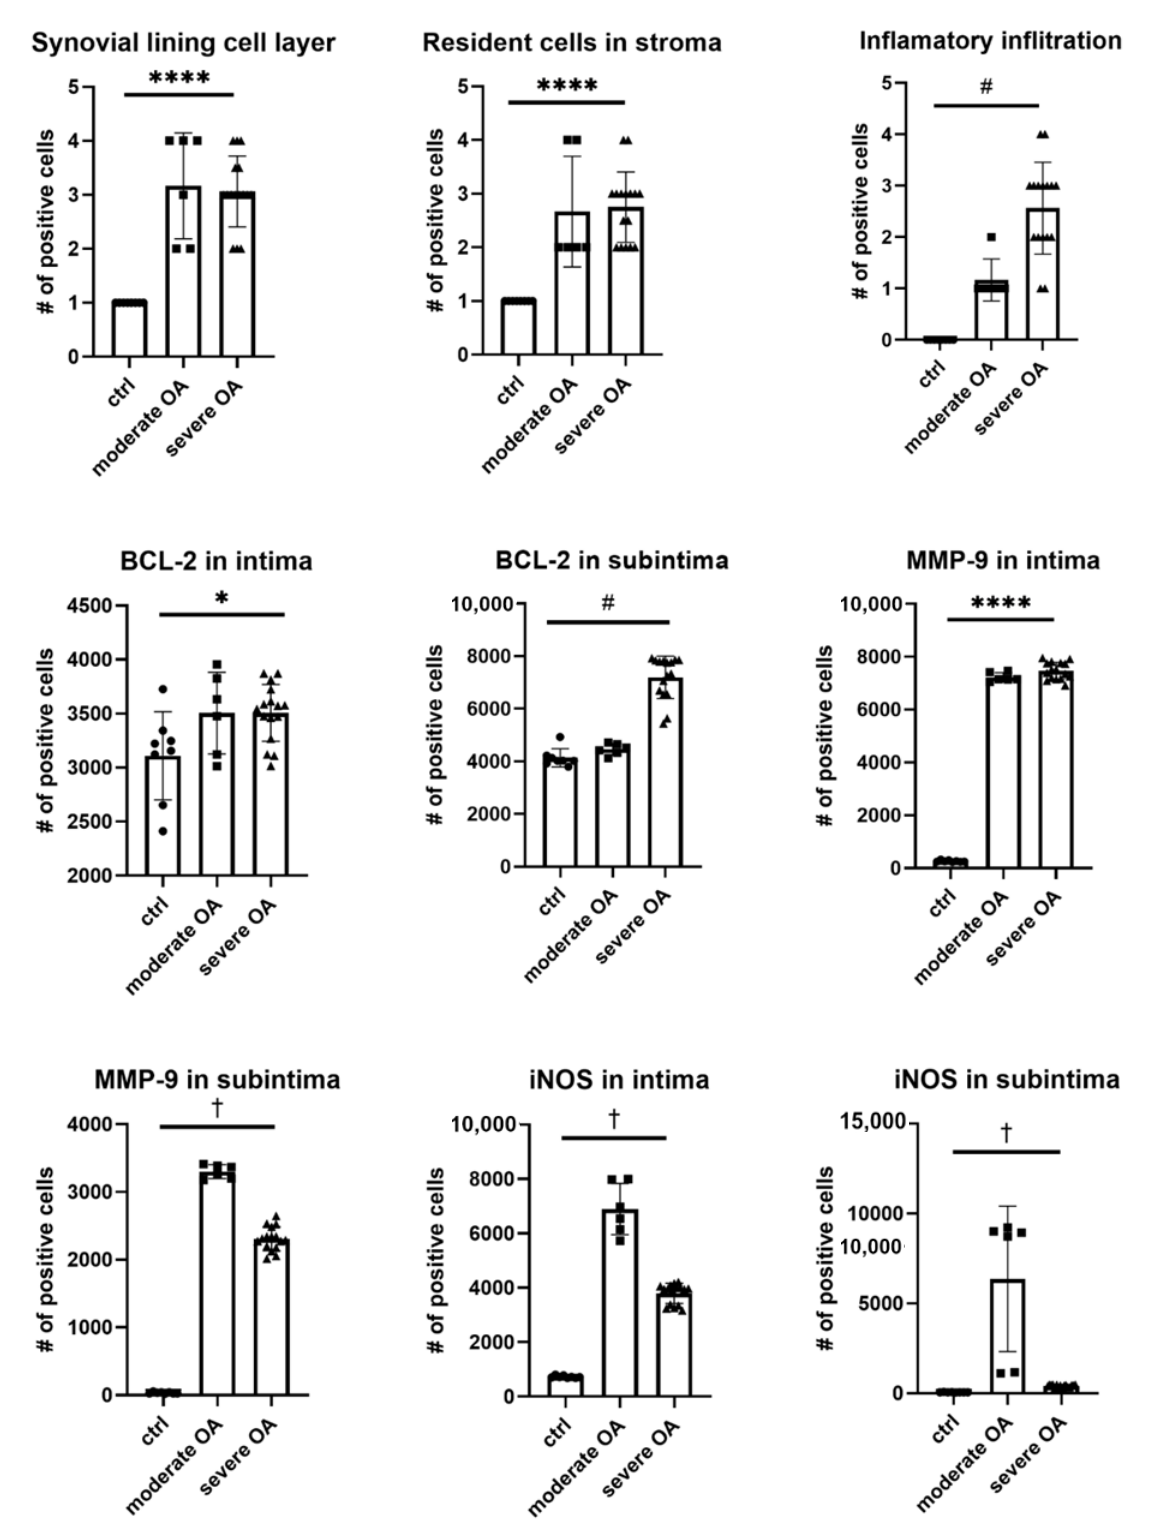
Figure 3. Pathological characteristics and expression of BCL-2, MMP-9 and iNOS in intima and subintima of hip OA patients. Legend: ctrl (control), osteoarthritis (OA); * p < 0.05, ****, p < 0.0001 for ANOVA; #, p < 0.05 for the test for linear trend; † p < 0.05 for the test for parabolic (quadratic) trend.